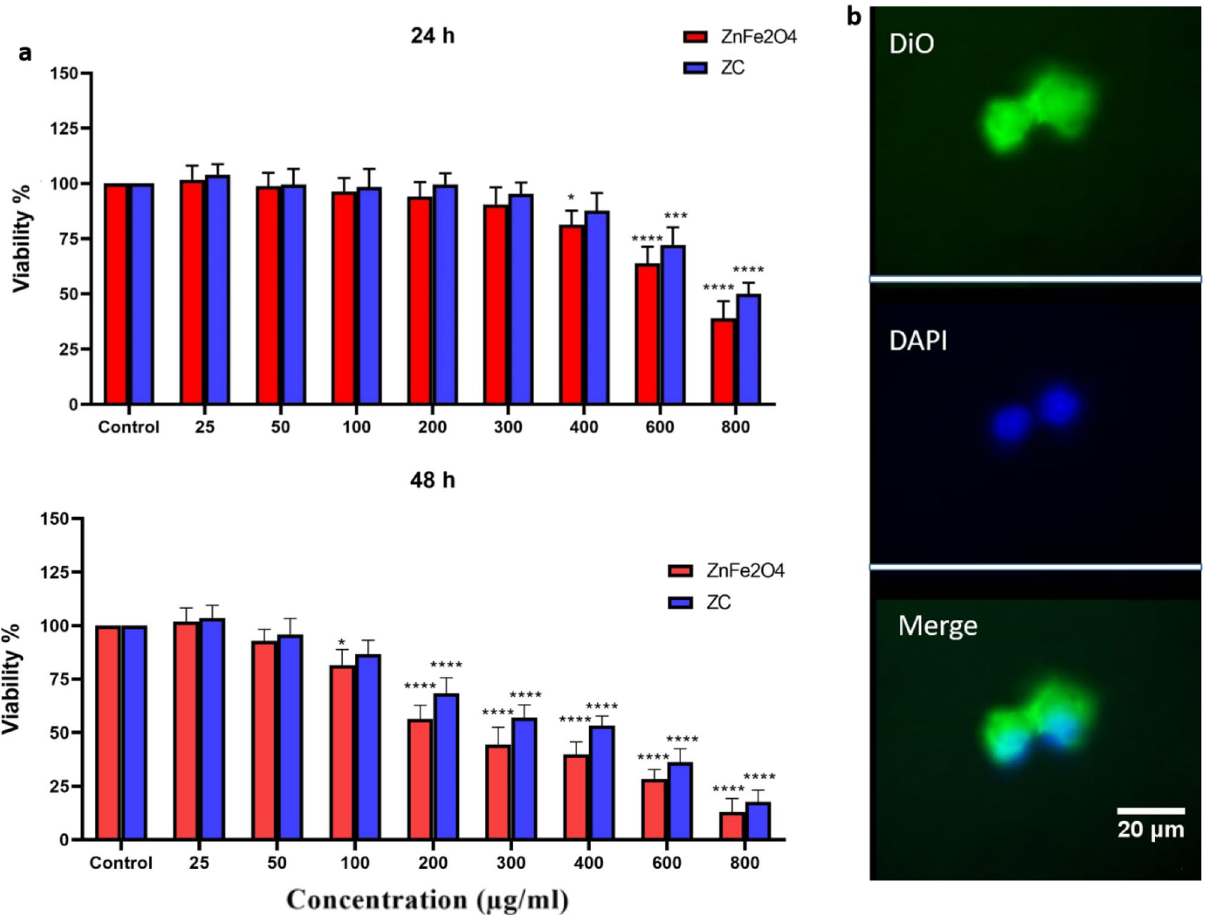
Figure 5. ( a ) MTT assay of ZnFe 2 O 4 and ZC against MCF-7 cells after 24 and 48 h, ( b ) Fluorescence images of MCF-7 cells: The ZC labeled with DiO (green) and the DAPI (blue) indicates the nucleus. The data points represent the mean ± sd of triplicates. *p < 0.05, *** p < 0.001, and ****p ≤ 0.0001 were considered statically significant according to a paired